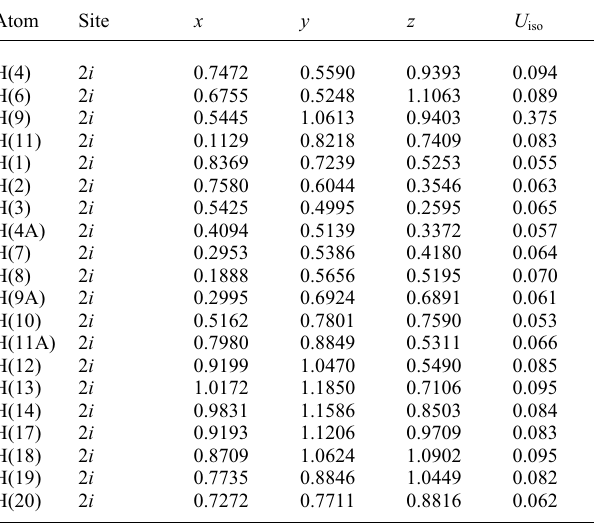
Table 2. Atomic coordinates and displacement parameters (in Å 2 )